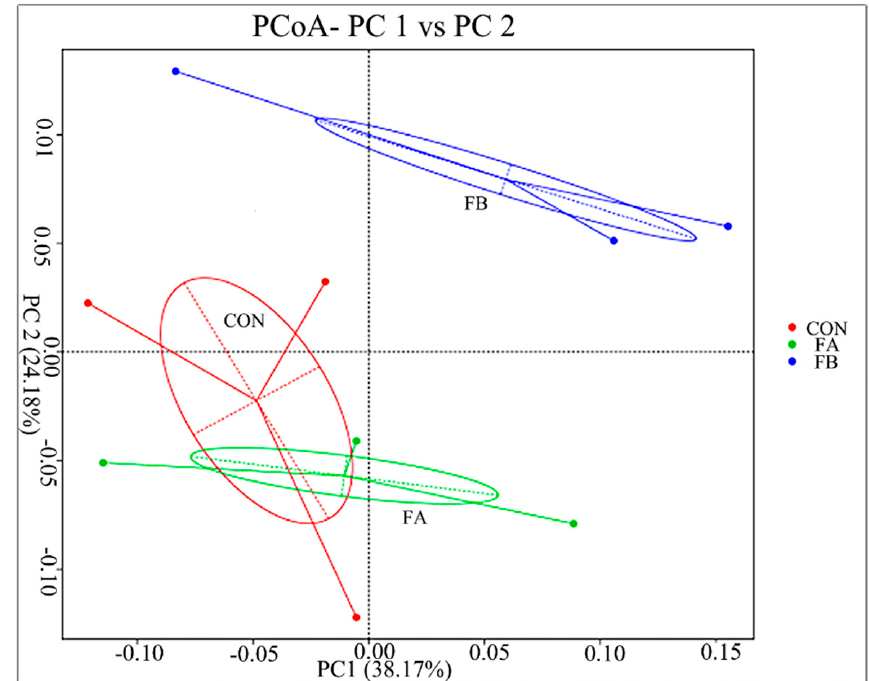
Figure 1. Bacterial diversity analysis of cecal microflora of laying hens fed different fermented diets (CON, red; FA, green; FB, blue) using principal coordinate analysis (PCoA) based on weighted UniFrac distances.